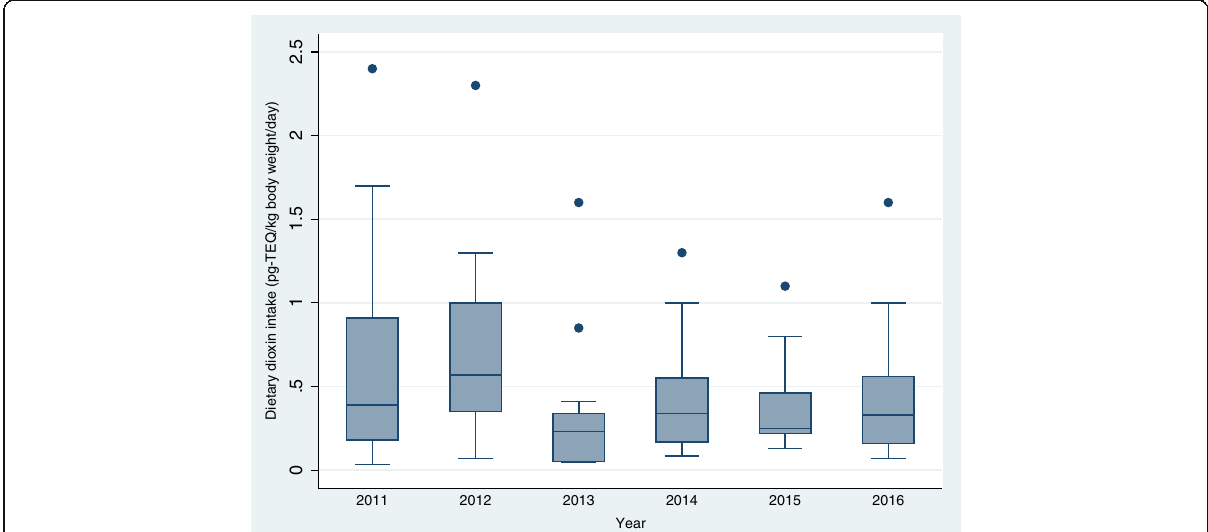
Fig. 3 (Showing whiskers): Estimated dioxin dietary intake by year ( n = 15/year). Box plot of total TEQ in food by survey year of the ‘ survey on the exposure to dioxins and other chemical compounds in humans, ’ 2011 to 2016 ( N = 90)The median (range) of dioxin dietary intake (in pg TEQ/kg body weight/day) by survey year was 2011, 0.39 (0.03 – 2.4); 2012, 0.57 (0.07 – 2.3); 2013, 0.23 (0.04 – 1.6); 2014, 0.34 (0.08 – 1.3); 2015, 0.25 (0.13 – 1.1); and 2016, 0.33 (0.06 – 1.6). Kruskal-Wallis test: χ 2 = 11.25; d.f. = 5; p = 0.046. TEQ, toxic